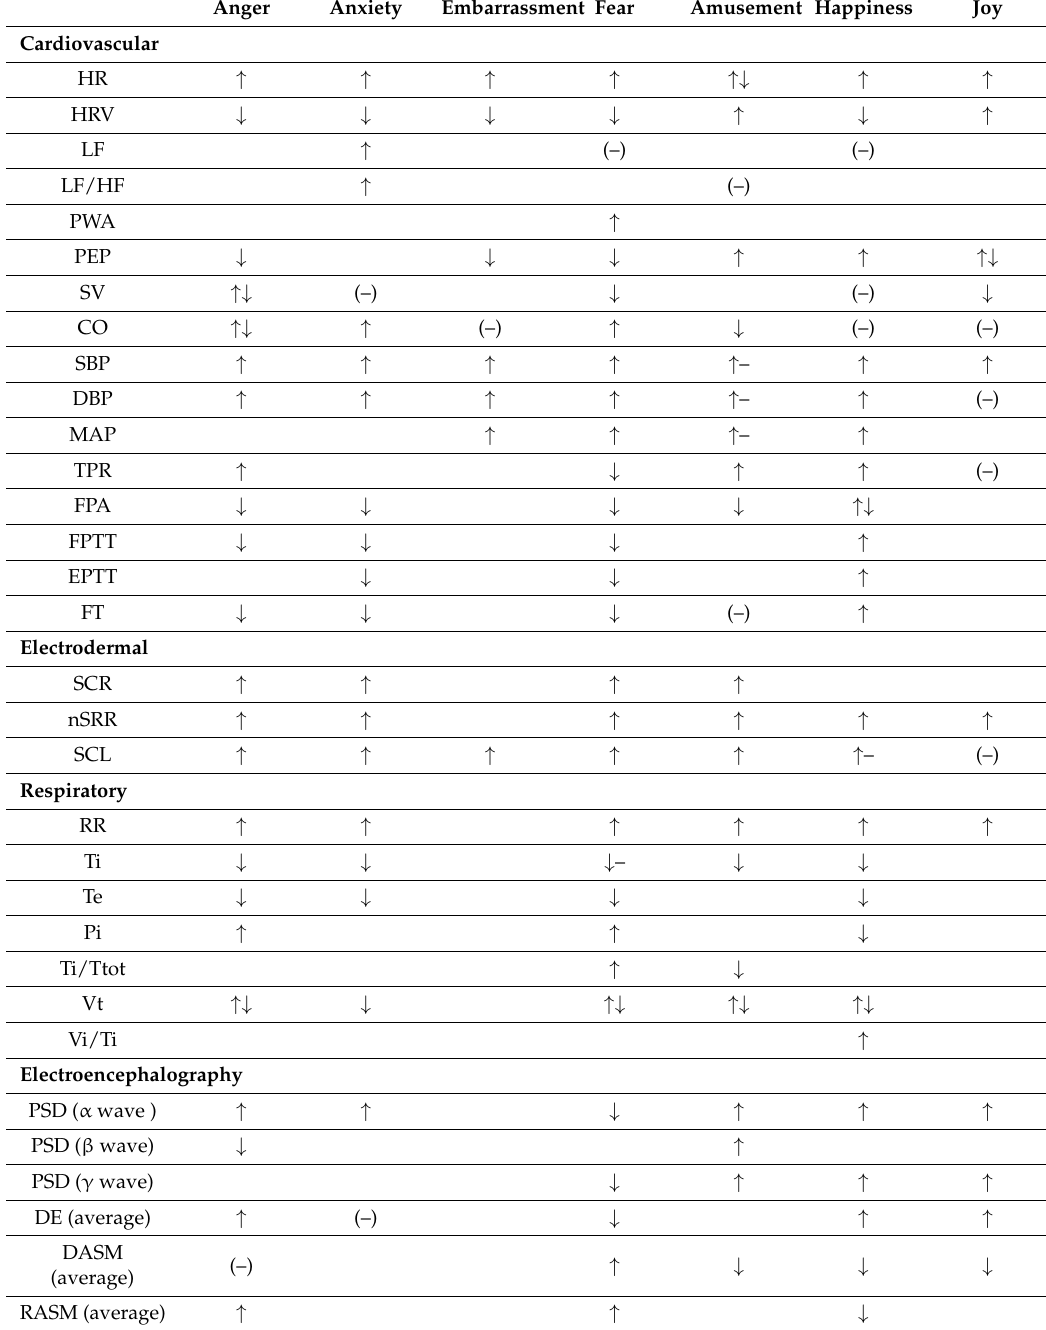
Table 1. The relationship between emotions and physiological features *